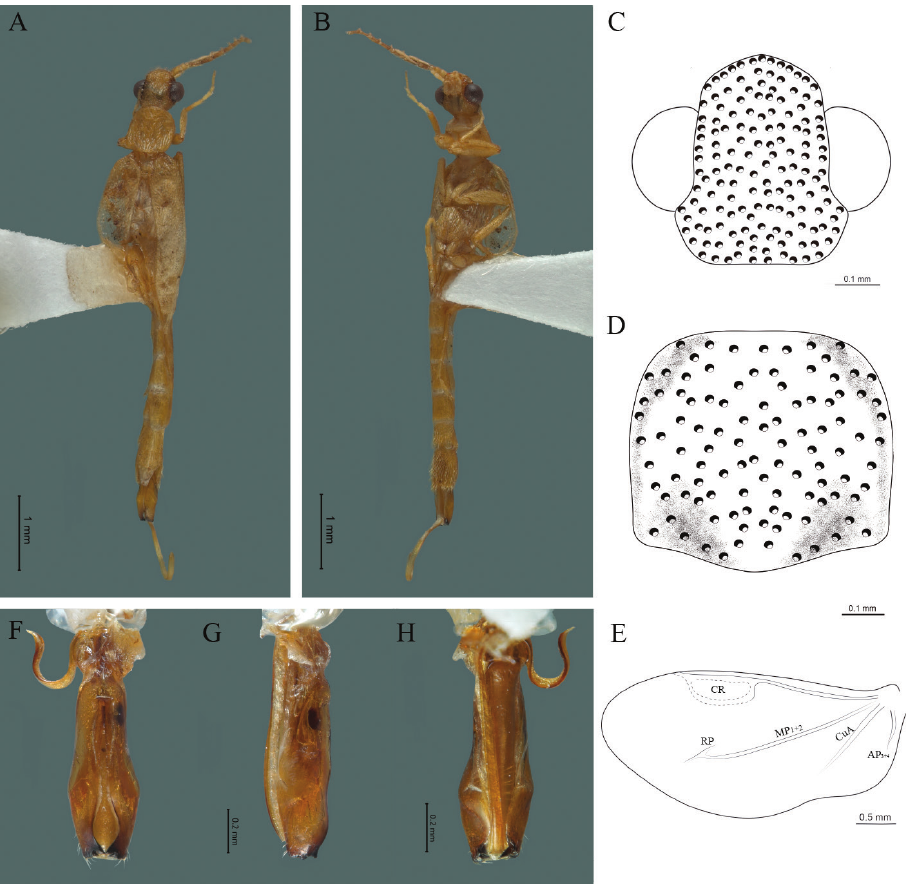
Figure 21. Cenophengus munizi Zaragoza-Caballero, 2008, male. Habitus: A dorsal B ventral C head dorsal D pronotum dorsal E hind wing. Wing venation: CR = Radial Cell; RP = Posterior Radial vein; MP1+2 = Posterior Median vein; CuA = Cubital vein; AP = Posterior Anal vein. Aedeagus: F dorsal view G lateral view H ventral